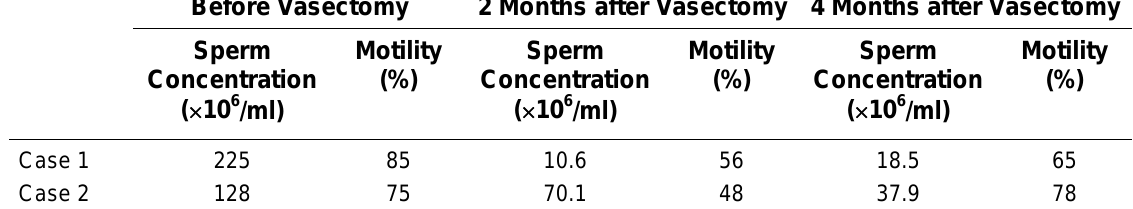
Sperm Concentration and Motility Found in Semen Analysis of Patients with Spontaneous Vas